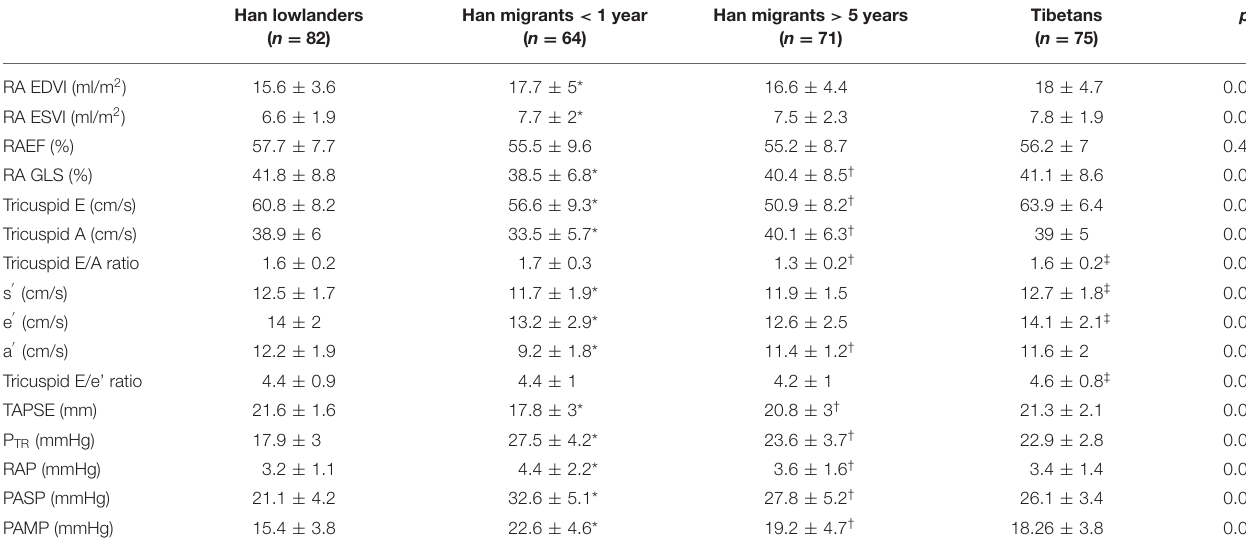
TABLE 2 | Echocardiographic parameters of right heart in Han lowlanders, Han migrants and native